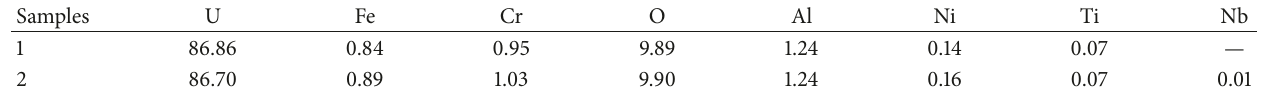
Figure 5: Local elemental analysis of metallic contaminations. Table 1: Elemental composition of researched sample surface in mass %.